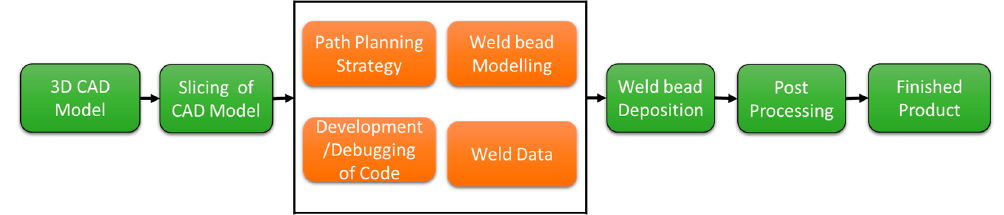
Figure 16. WAAM process